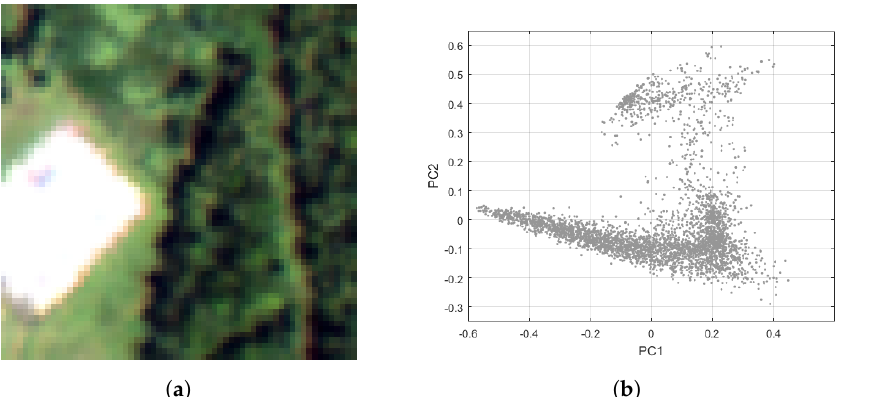
Figure 3. Fort A.P. Hill image chip: ( a ) true-color composite, and ( b ) scatter plot for the the first-two principal components (PC-1 in the horizontal axis and PC-2 in the vertical axis).